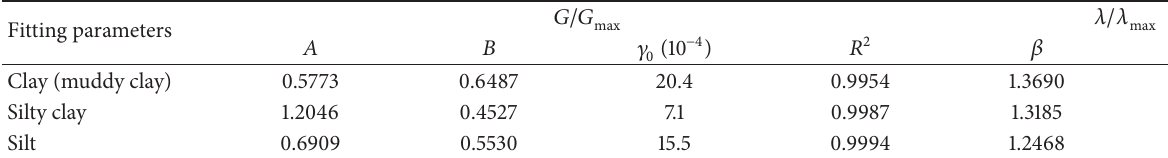
Table 2: The fitting parameters and the correlation coefficients 𝑅 2 .